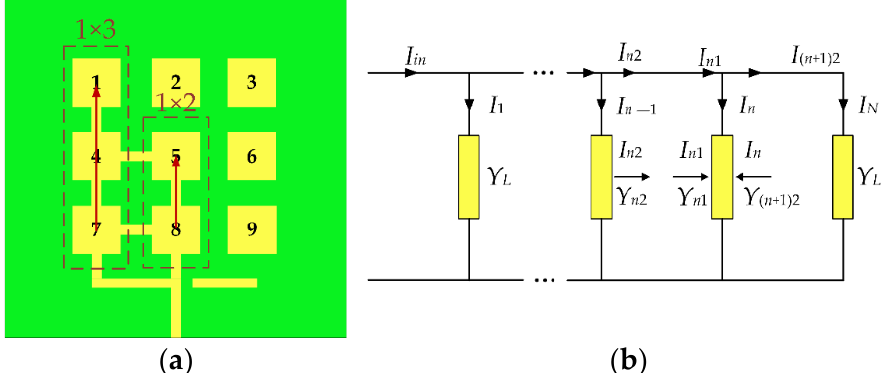
Figure 7. ( a ) Schematic of the Mode 3 antenna series-fed patch antenna array; ( b ) equivalent circuit diagram of the series-fed patch antenna array.